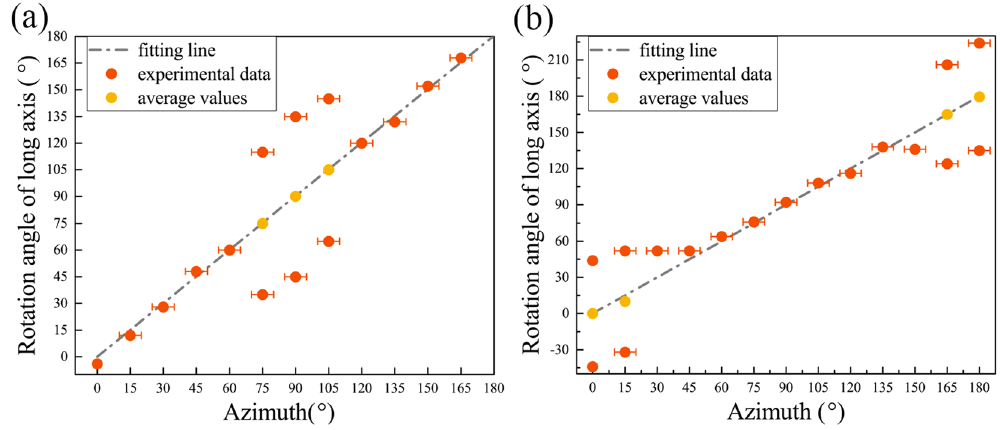
Figure 3. Azimuth angle dependences of the major axes of SHG patterns under ( a ) perpendicular and ( b ) parallel configurations. Error bars in these figures are from changing the sample azimuth angle manually.